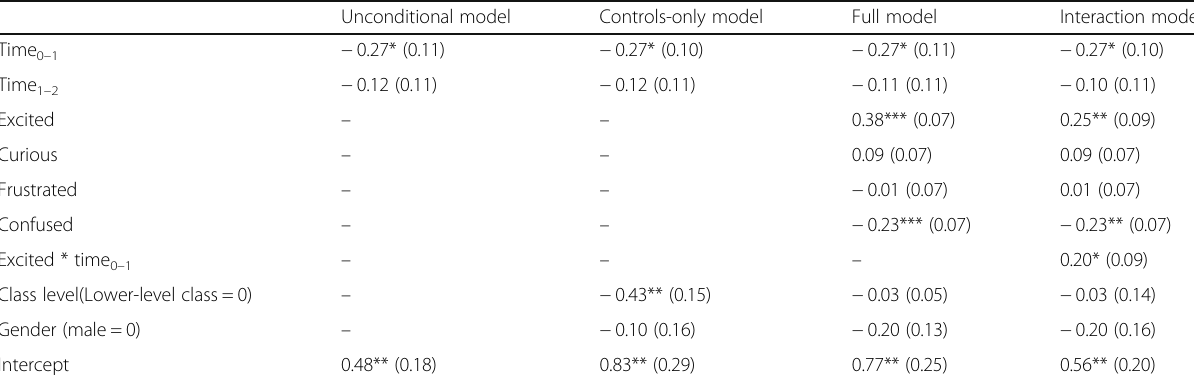
Table 4 Piecewise growth model of makerspace